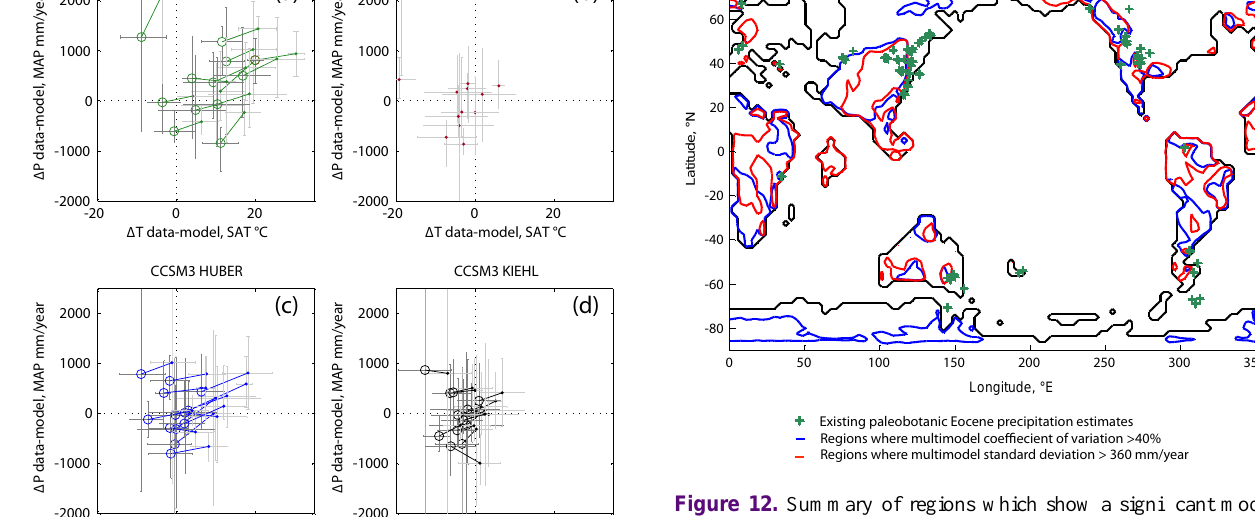
Figure 12. Summary of regions which show a significant model spread, based on the Eocene multimodel mean described in Fig. 5. Paleobotanical estimates of quantitative precipitation rate included in the data compilation are shown by green markers. Regions where the standard deviation is greater than 1mmday − 1 (i.e. 360mmyr − 1 ) are marked by a red outline and regions where the coefficient of variation (standard deviation/multimodel mean) is greater than 40% are outlined